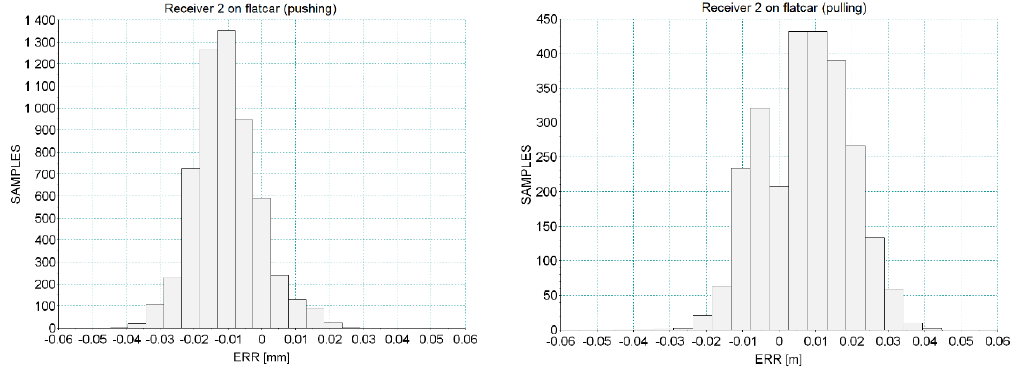
Figure 16. Histograms of errors for di ff erent GNSS signals in relation to the tacheometry measurements. Table 2. Mean and σ values calculated from the ERR signal before and after the versine e ff ect correction. Before Corrections After Corrections Method Mean ERR [mm] σ ERR [mm] Mean ERR cor [mm] σ ERR cor